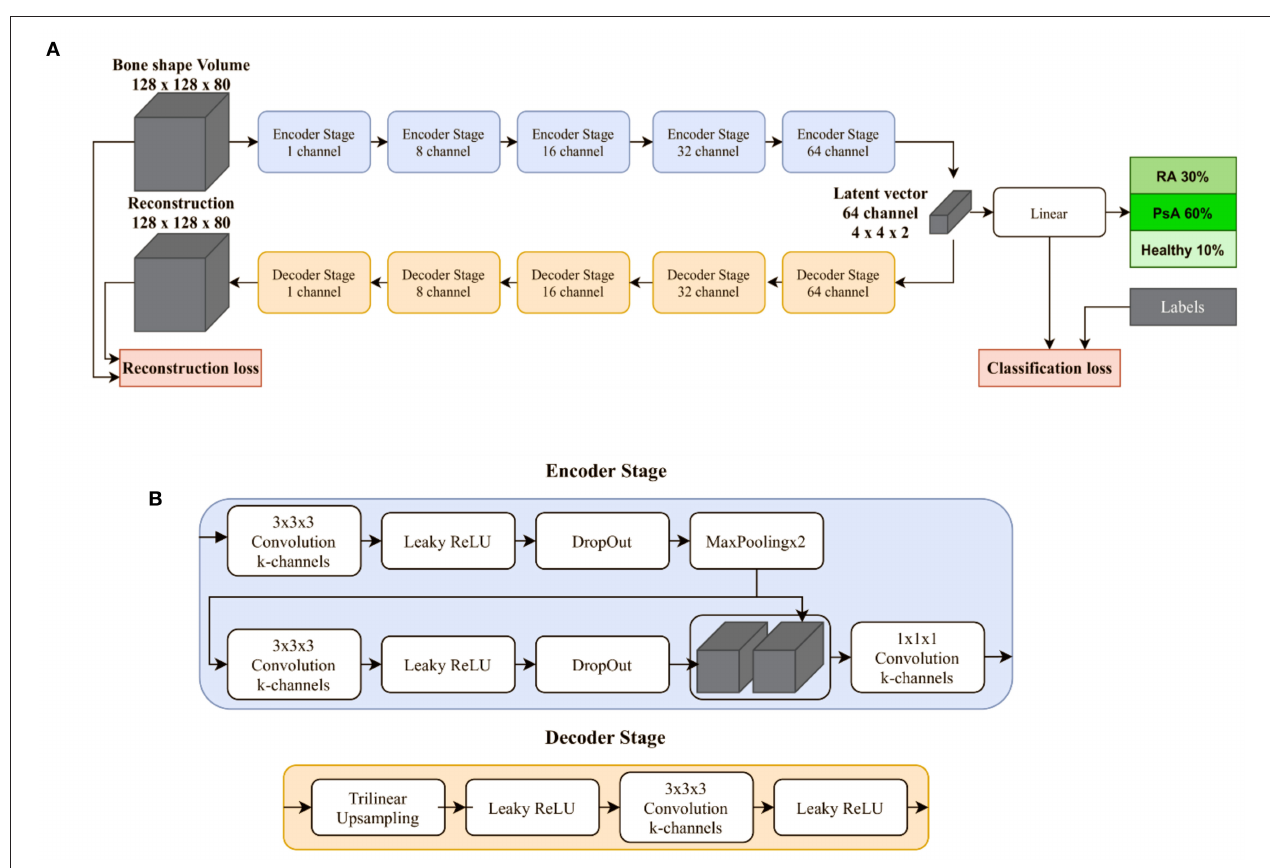
FIGURE 1 | Deep learning model for the classification of joint shapes. (A) Proposed deep learning model termed Convolutional Supervised Auto-Encoder (CSAE) model consists of five stages each for the encoding and decoding branch. Stages closer to the linear classification layer have an increasing number of channels. (B) A single encoder consists of two 3 × 3 × 3 convolution followed by a Leaky ReLU activation function and three-dimensional dropout. Maximum pooling with a factor of two is used for down-sampling. The decoding branch is used to generate features in the bottleneck that are discriminative of the